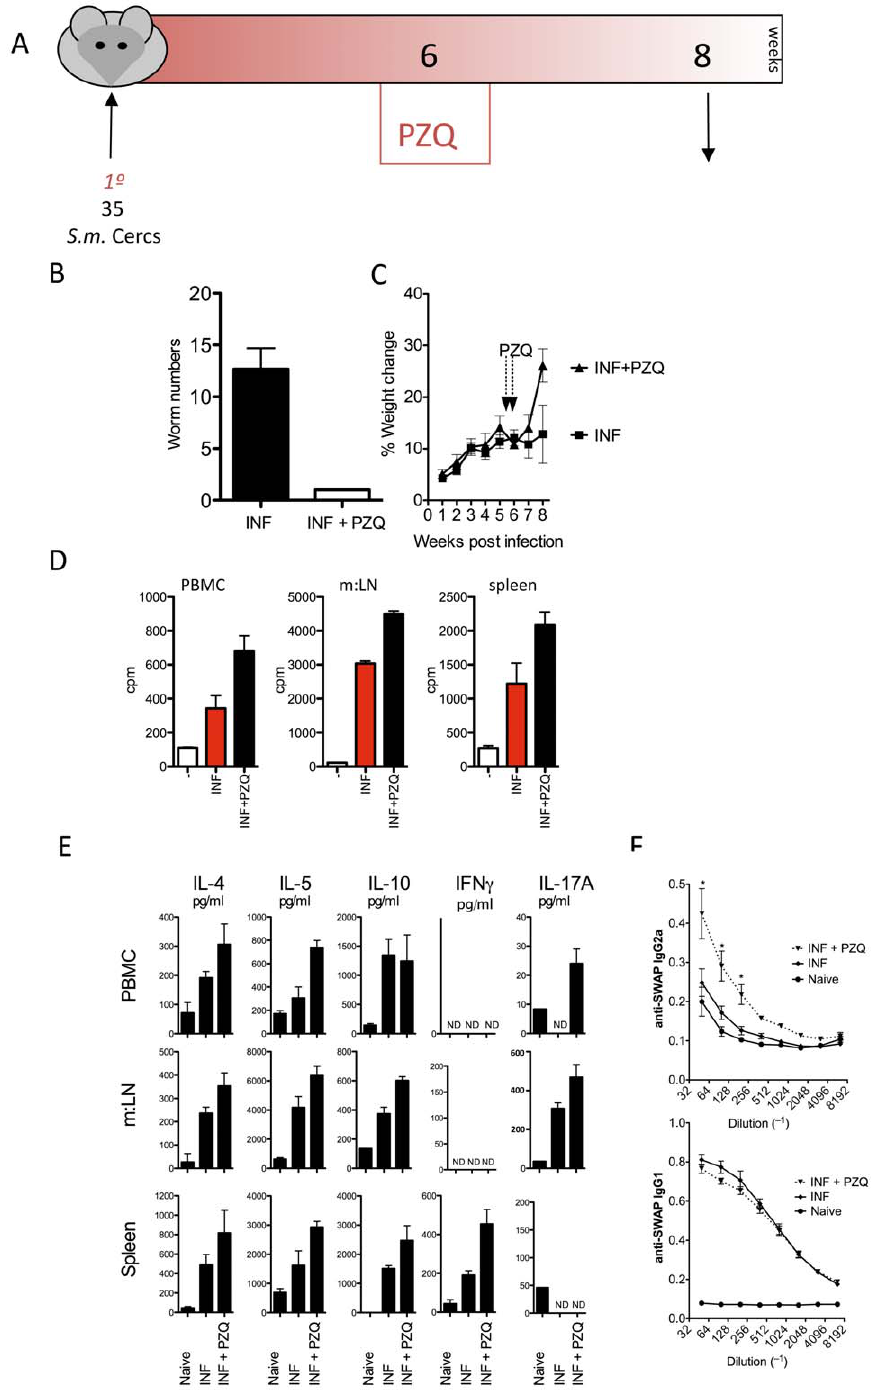
Figure 1. Elevated anti-worm responses post PZQ treatment. C57BL/6 mice were infected with 35 cercariae before treatment with 2 doses of PZQ at week 6. Mice were killed at week 8 for analysis. 10 mice per group were used. Data shown are from one of 3 experiments, with mean 6 SEM. (A) Experimental model diagram. (B) Total worm numbers at week 8. 2-weeks post PZQ. (C) Weight change throughout 8-week period. (D) Tritiated [H] 3 thymidine incorporation in peripheral blood-derived leukocytes, mesenteric lymph nodes and splenocytes following adult worm antigen re- stimulation. (E) Cytokine secretions, measured by ELISA, from adult worm antigen re-stimulation, as in D. (F) Anti-worm antibody responses, measured by ELISA. doi:10.1371/journal.ppat.1002171.g001 ( Figure S2 A, B, C ). Of particular interest, we observed a presented in figure 2 , the increased effector responses ( Figure 2 ) significant increase in IL-10-prodcuing cells in PZQ-treated mice, appeared to be mirrored by a significant expansion of IL-10- compared to challenge-only mice ( Figure 3 ). Together with data producing cells ( Figure 3 ). Furthermore, we also observed a